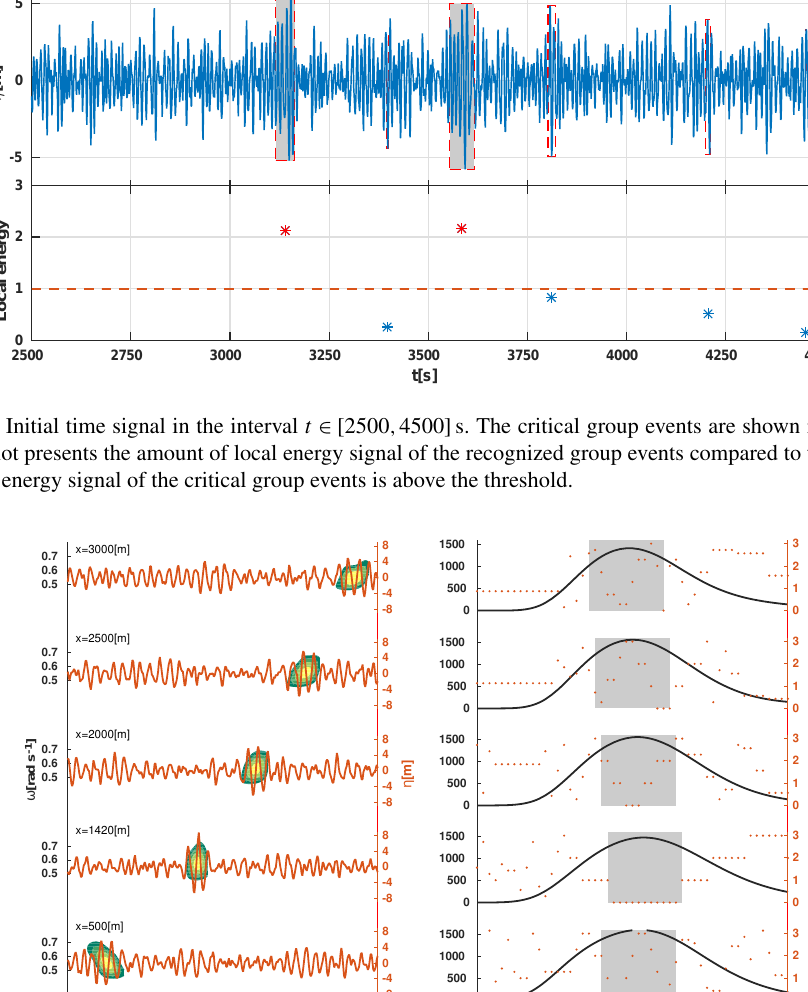
is a freak wave threshold normalized by the amplitude of a maximal signal. Based on their local energy, these critical group events could generate a freak wave forward or back- ward, but the probability depends on the phases.